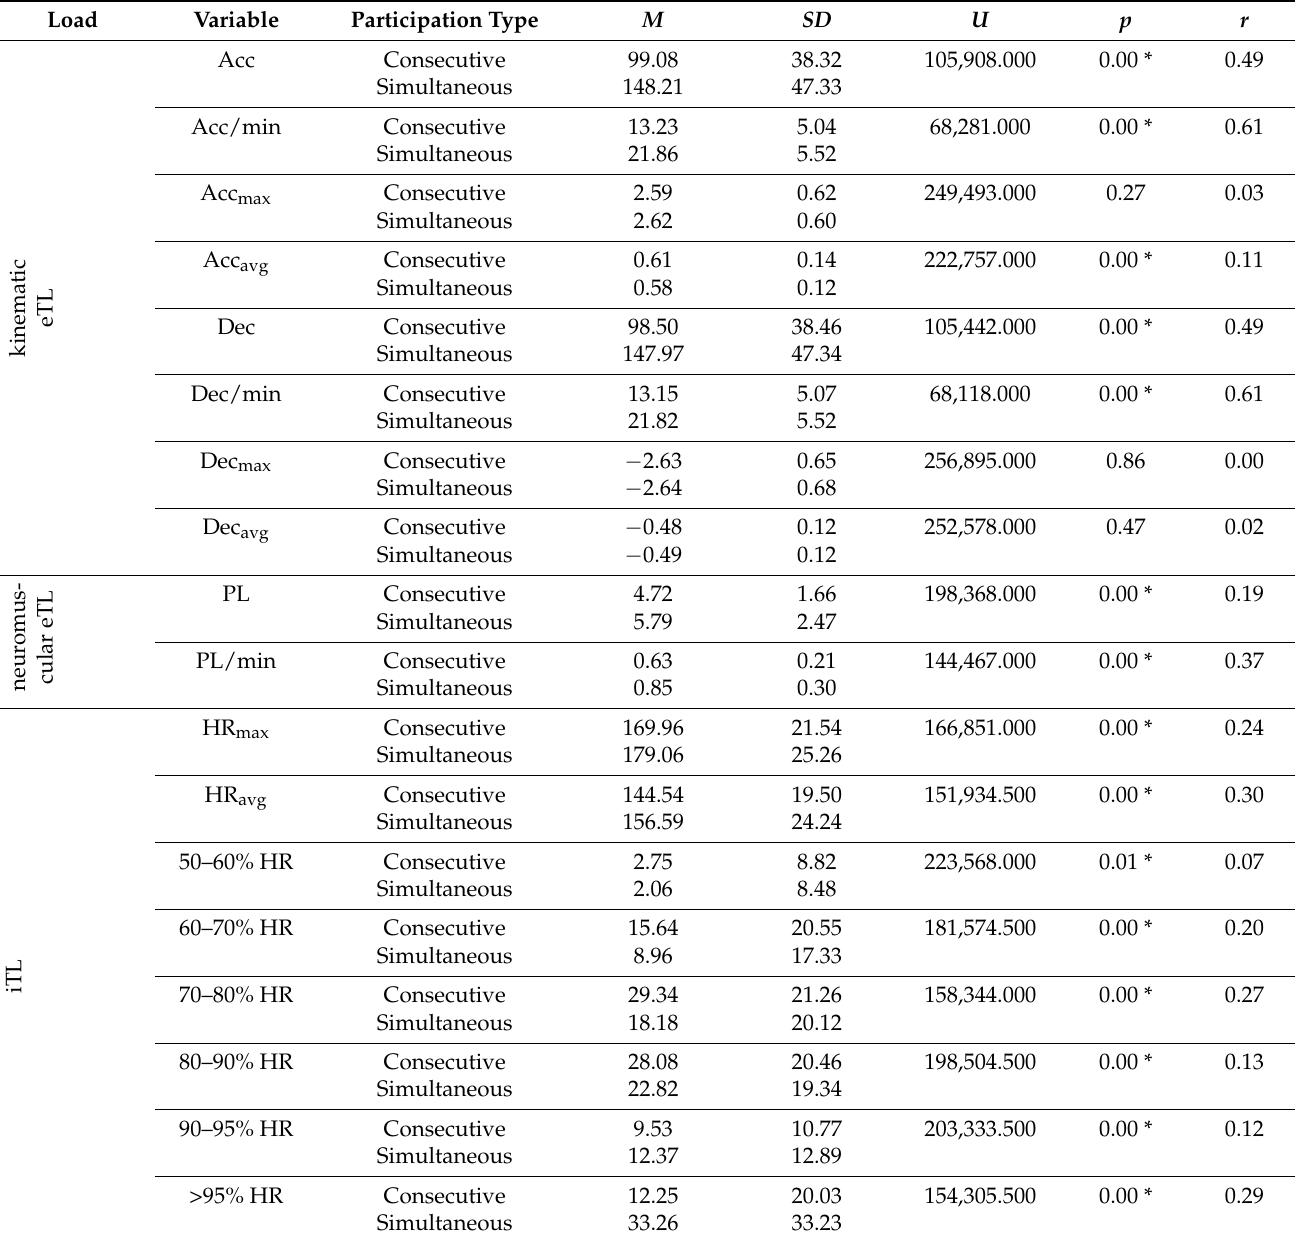
Table 2. Inferential results of the variables studied independently according to the participation